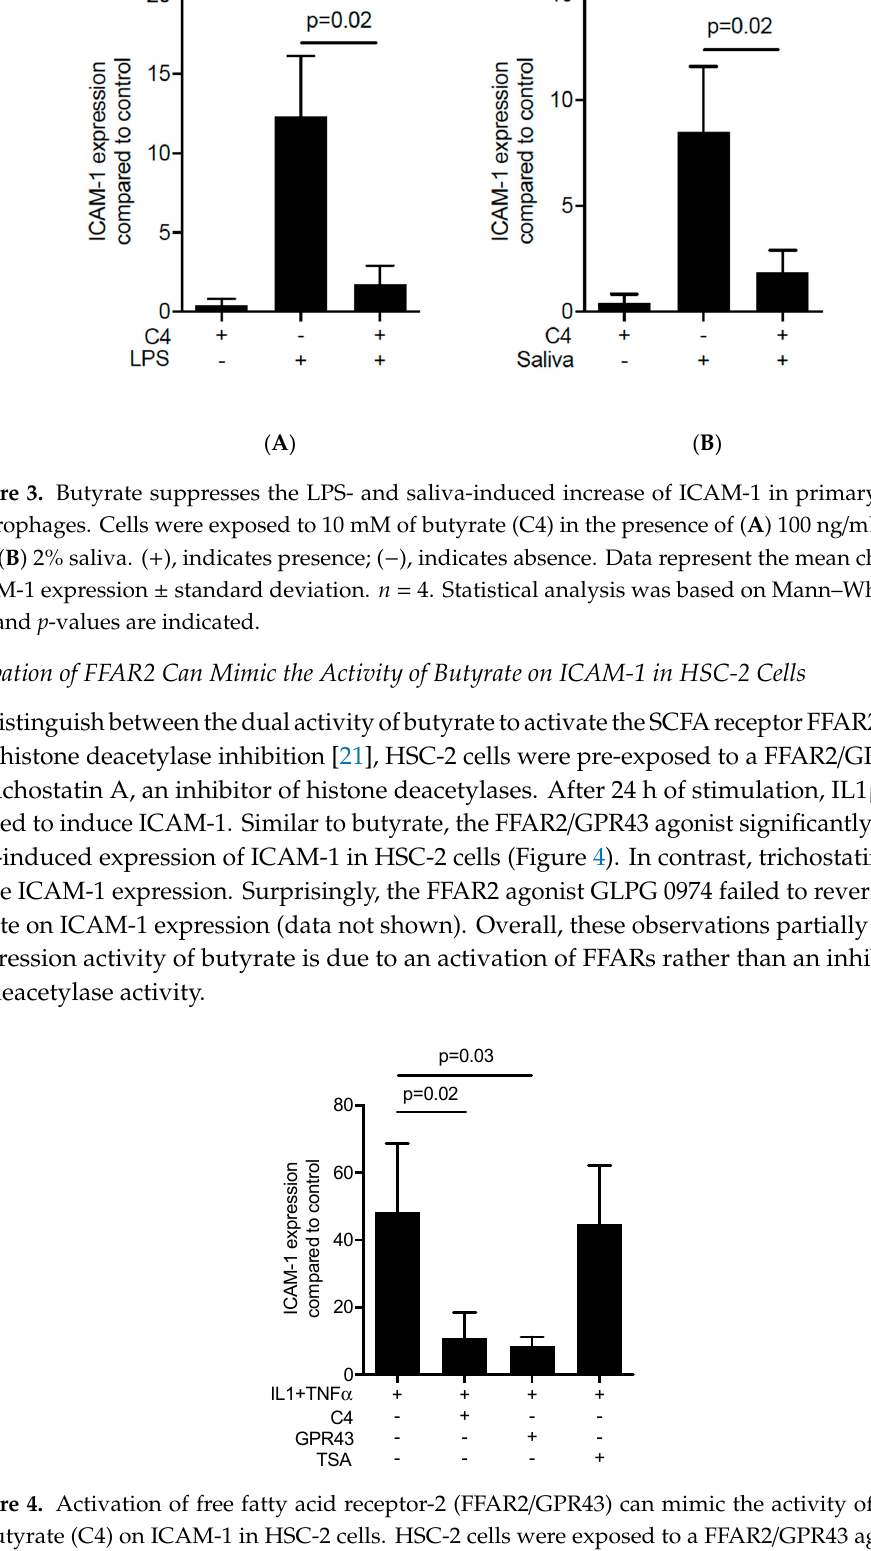
Figure 5. Butyrate suppresses NF- κ B p65 translocation in inflamed HSC-2 cells. Butyrate at 10 mM attenuates the intracellular translocation of NF- κ B p65 into the nucleus, induced by 10 ng/mL IL1 β and TNF α in HSC-2. (wo), without. Representative immunofluorescence at 40x. 2.5. Butyrate Cannot Reverse the Acute Expression Levels of ICAM-1 in HSC-2 Cells In the previous experimental setting, HSC-2 cells were exposed to butyrate for 24 h, before the incubation with IL1 β and TNF α , simulating a prophylactic effect of butyrate. To investigate the possible role of butyrate in dampening the acute ICAM-1 expression, HSC-2 cells were exposed to IL1 β and TNF α for 1 h and then butyrate was added for another 3 h. In this setting, butyrate failed to modulate the ICAM-1 expression in HSC-2 cells suggesting that butyrate can prevent but not reverse an ongoing ICAM-1 expression in inflammatory conditions (Figure 6). Moreover, three hours of pre- exposure of HSC-2 cells with butyrate also failed to reduce the IL1 β and TNF α -induced increase of ICAM-1, suggesting that a longer period of pre-incubation with butyrate is critical to obtain aICAM- 1 modulation [53].